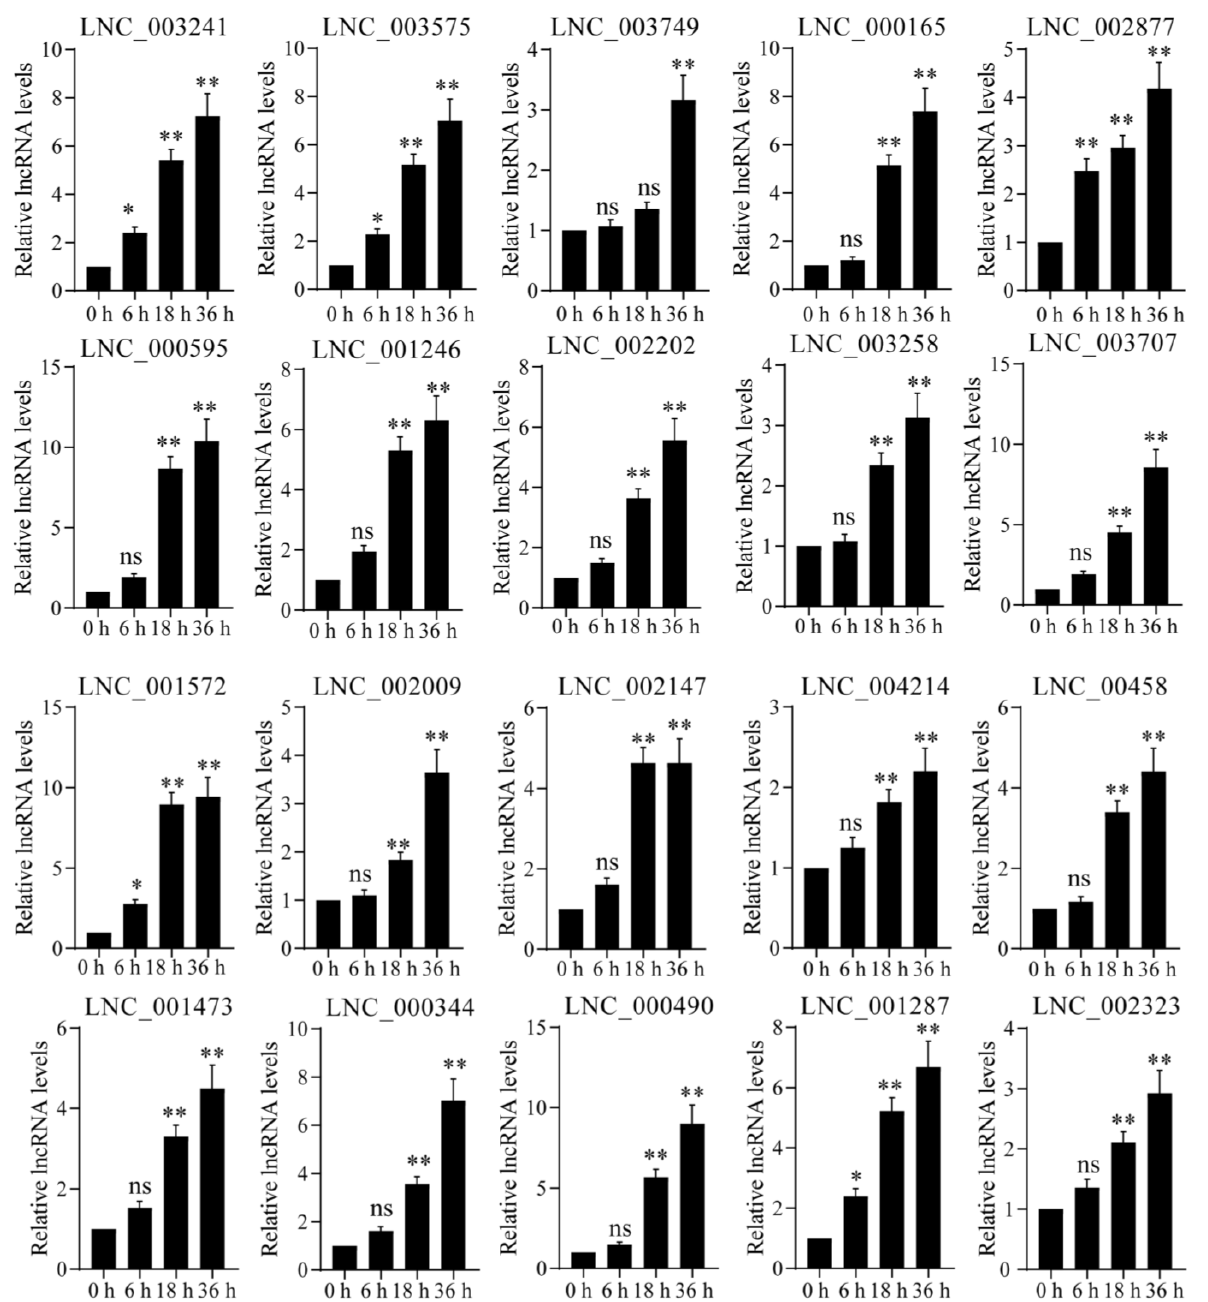
Figure 4. Key DELs of the plant-pathogen interaction pathway were up-regulated under UV-B radiation. The gene expression levels were analyzed by quantitative RT-PCR analysis; the Y -axis indicates the relative expression level; the X -axis indicates UV-B treatment time (h); The data were calculated from three biological replicates. Vertical bars are the means ± SEM. Significant difference (ns p > 0.05, * p < 0.05, ** p <